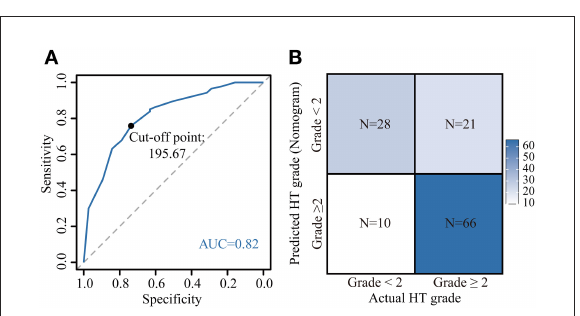
FIGURE6 Application of the nomogram. Risk stratification constructed by calculating the optimal cut-off value of the total point by the receiver operating characteristic (ROC) curve (A) . [A total point below 195.67 was included in the low-risk group (risk of acute HT < 2), otherwise the high-risk group (risk of acute HT ≥ 2)]. Confusion matrix for assessing differences between